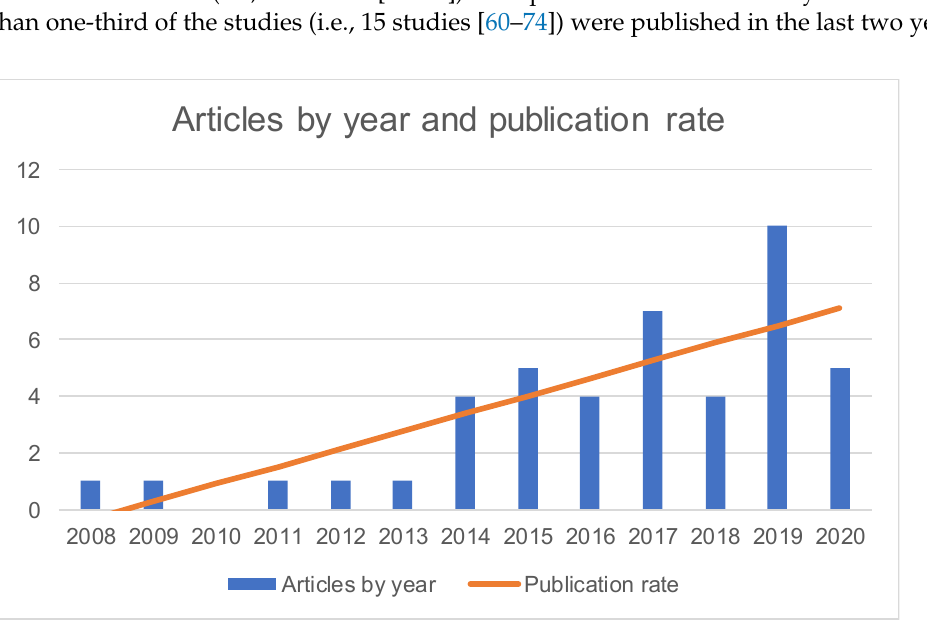
Figure 2. Studies by year and publication rate (calculated using RMS Least Square Fit). The Figure 3 represents the distribution of the included studies by country. Europe has the highest contribution (i.e., 43 studies). Comparatively, the remaining regions of the world have relatively residual contributions: together, North America, South America and Asia contributed with three